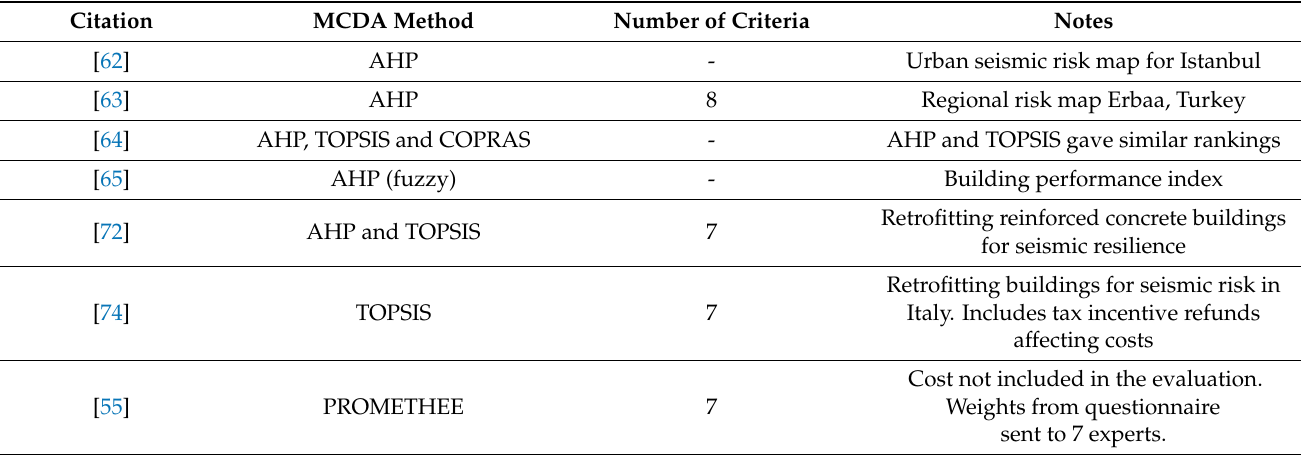
Table 7. Examples of MCDA applications in Earthquake Engineering